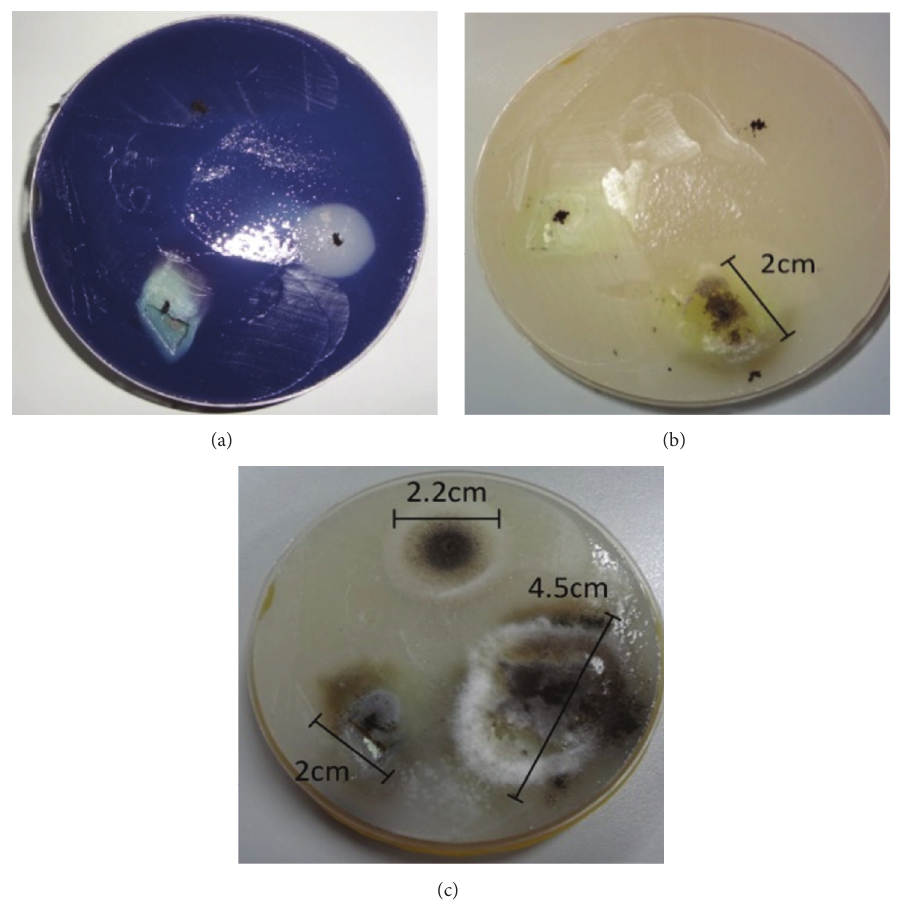
Figure 7: Silver iodide from conductance in (a) placement of molds, (b) 6 days after placement of molds, and (c) 10 days after placement of molds.